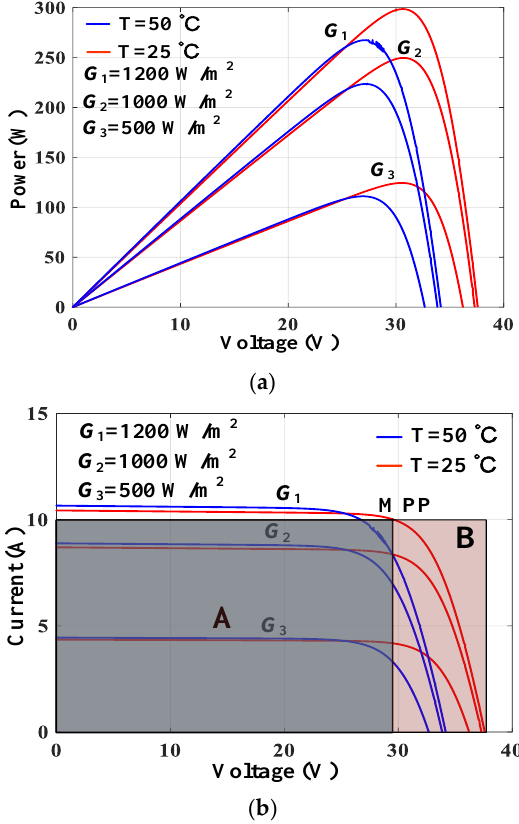
Figure 3. PV characteristic curves at various G and T ( a ) P-V ( b ) I-V. As shown in Figure 3, the P-V and I-V curves are the unimodal function with only one MPP. In addition, the fill factor (FF) is commonly used to evaluate the dynamic quality of PV arrays [18], and the value of FF is usually between 60% and 80%, as shown in Equation (4). Since MPPT algorithms can maximize the extracted PV power, the working state of PV array can be as close to the MPP as possible by the MPPT algorithm. The MPP voltage of the PV array at various G and T is given in Figure 4.